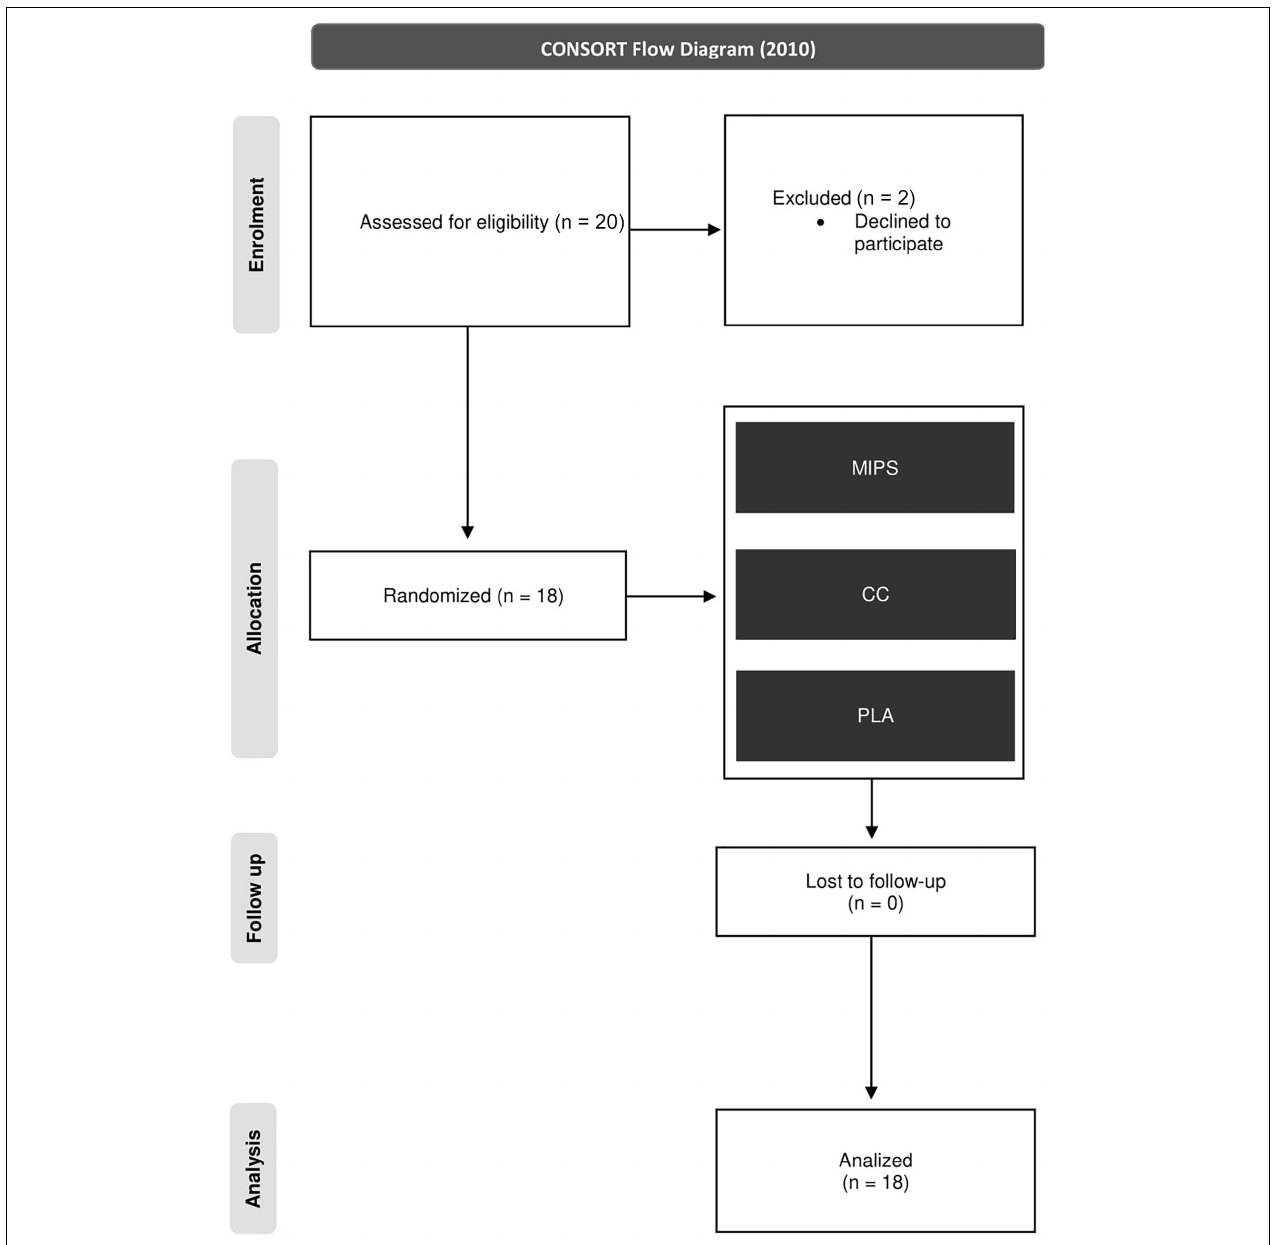
FIGURE 1 | CONSORT